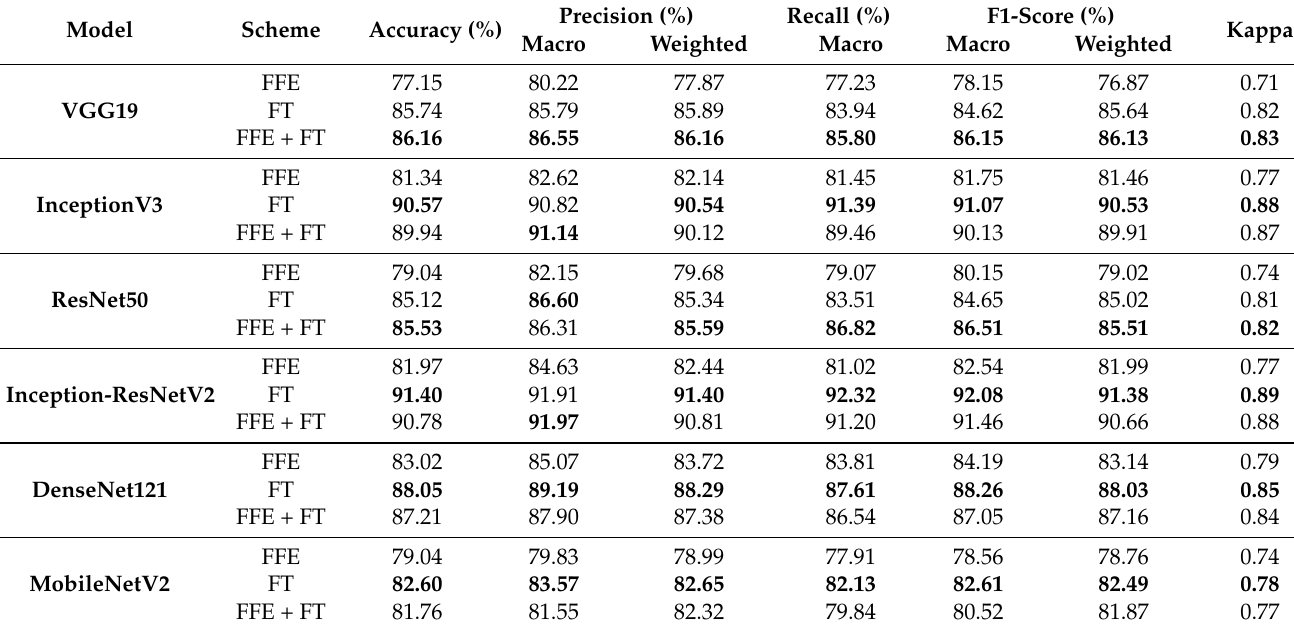
Table 5. Evaluation of NN classifiers on the test set. Since the value of the weighted recall is equal to the value of accuracy, we present only macro recall